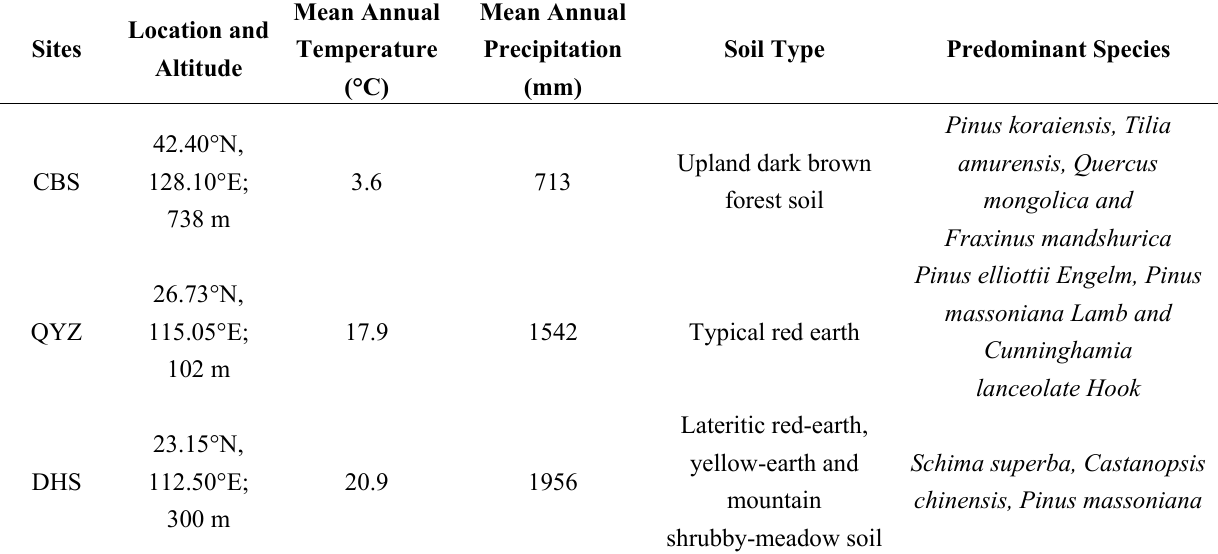
Table 1. Site descriptions (Changbaishan temperate mixed forest (CBS),